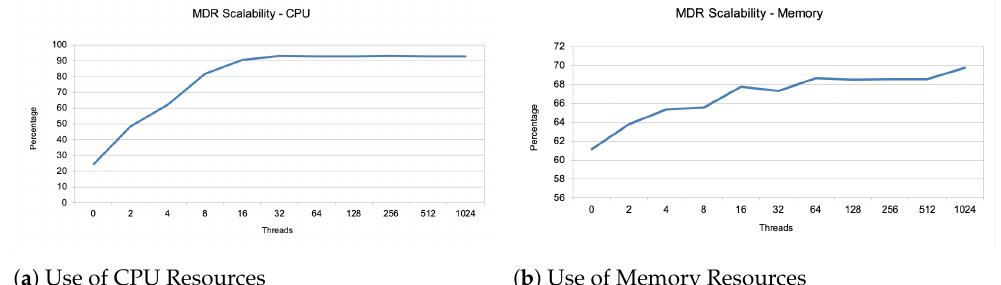
Figure 4. Metadata Repository (MDR) scalability